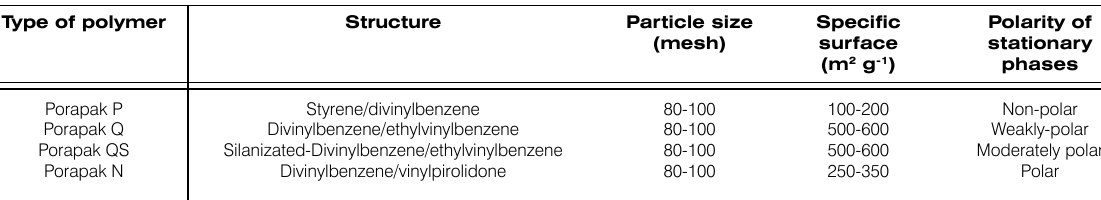
Table 1. The characteristics of porous polymers used in SPE Type of